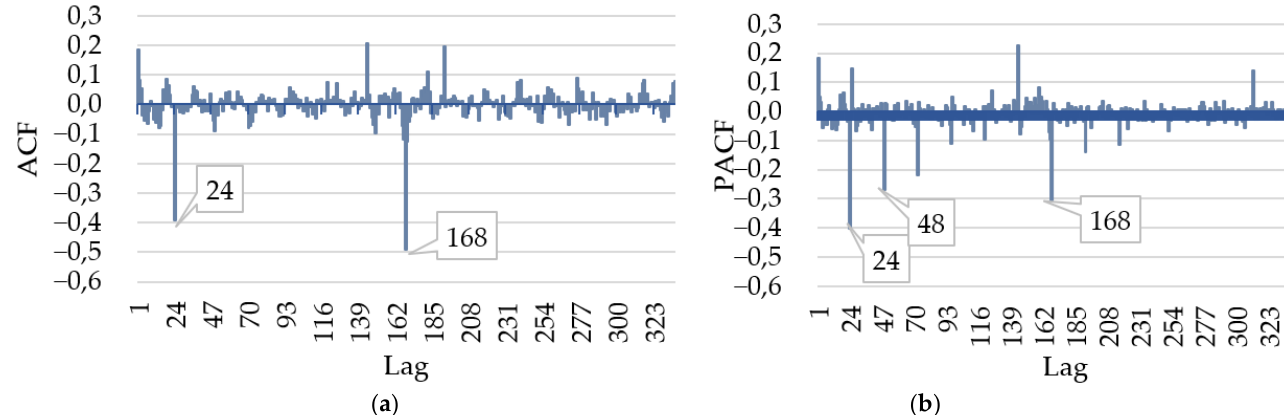
Figure 6. ACF and PACF functions of differentiated time series (1 – B )(1 – B 24 )(1 – B 168 ) Y t . ( a ) ACF, ( b ) PACF. ACF function plot (significant values for delays 1, 24, and 168) and PACF function plot (combination of exponential decays starting from delays 1, 24, and 168) indicate the ARIMA(0,1,1)(0,1,1) 24 (0,1,1) 168 model. The ARIMA(0,1,1)(0,1,1) 24 (0,1,1) 168 model is stationary and reversible. It may